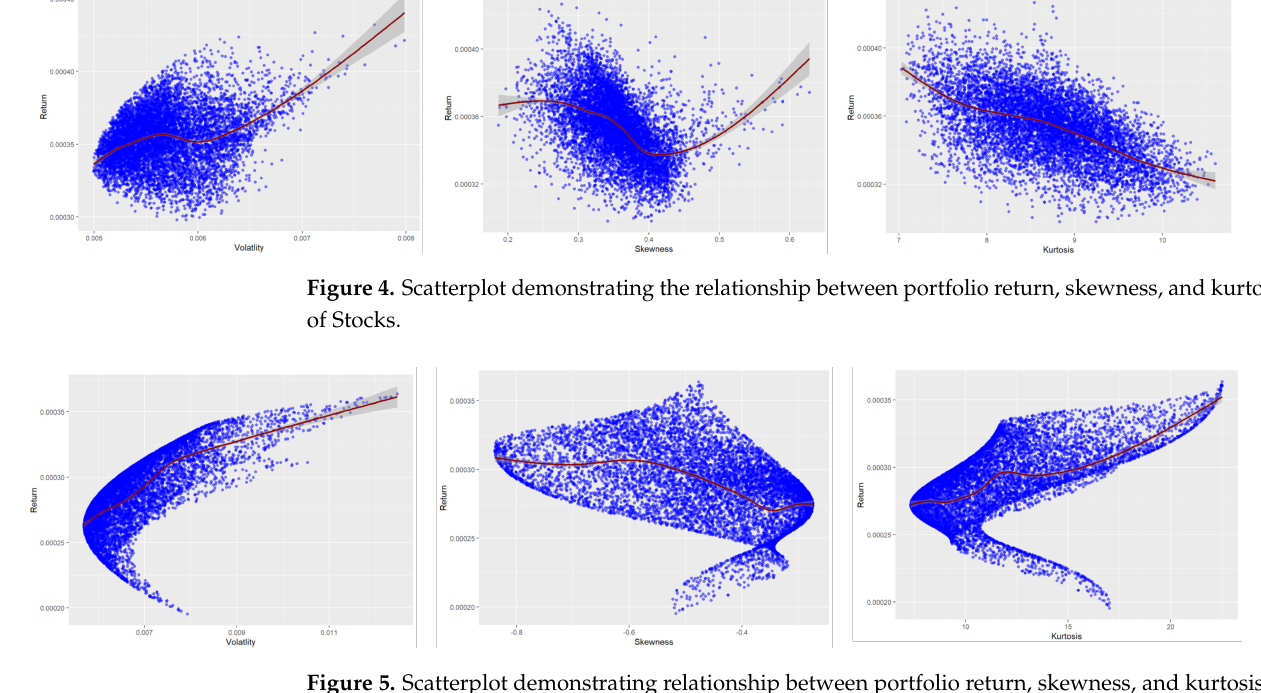
Figure 5. Scatterplot demonstrating relationship between portfolio return, skewness, and kurtosis of Cryptocurrencies (Group 1).